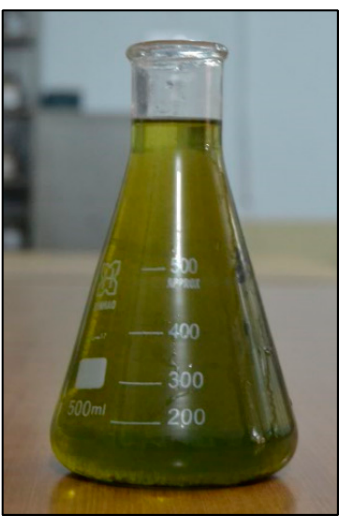
Figure 3. Effluent from dyeing industry (Acidic).